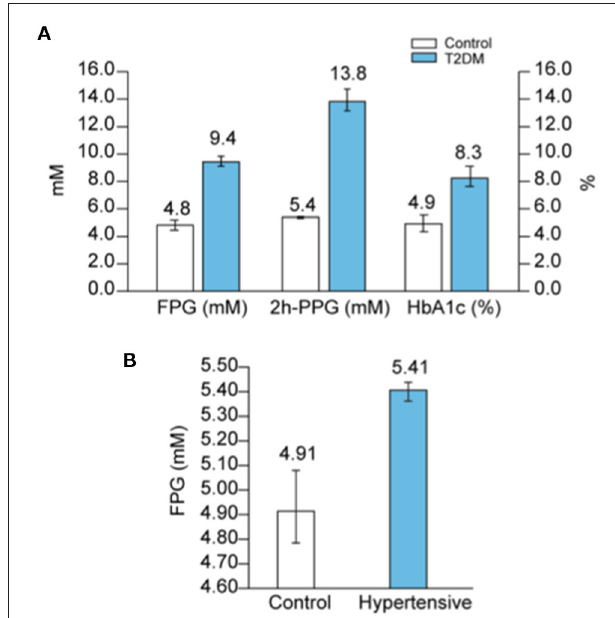
FIGURE 9 | Blood glucose in diabetes and hypertension. (A) Average values of FPG, 2h-PPG and HbA1c in diabetic people compared to controls were calculated according to raw data reported in several studies as detailed in Supplementary Table 4A , and reported. (B) Average values of FPG in hypertensive patients compared to controls were calculated according to raw data reported in several studies as detailed in Supplementary Table 4B , and